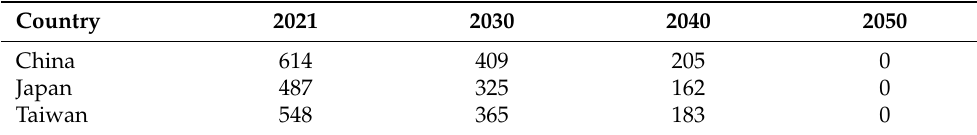
Table 3. Electricity grid’s CO 2 emission factor (kg CO 2